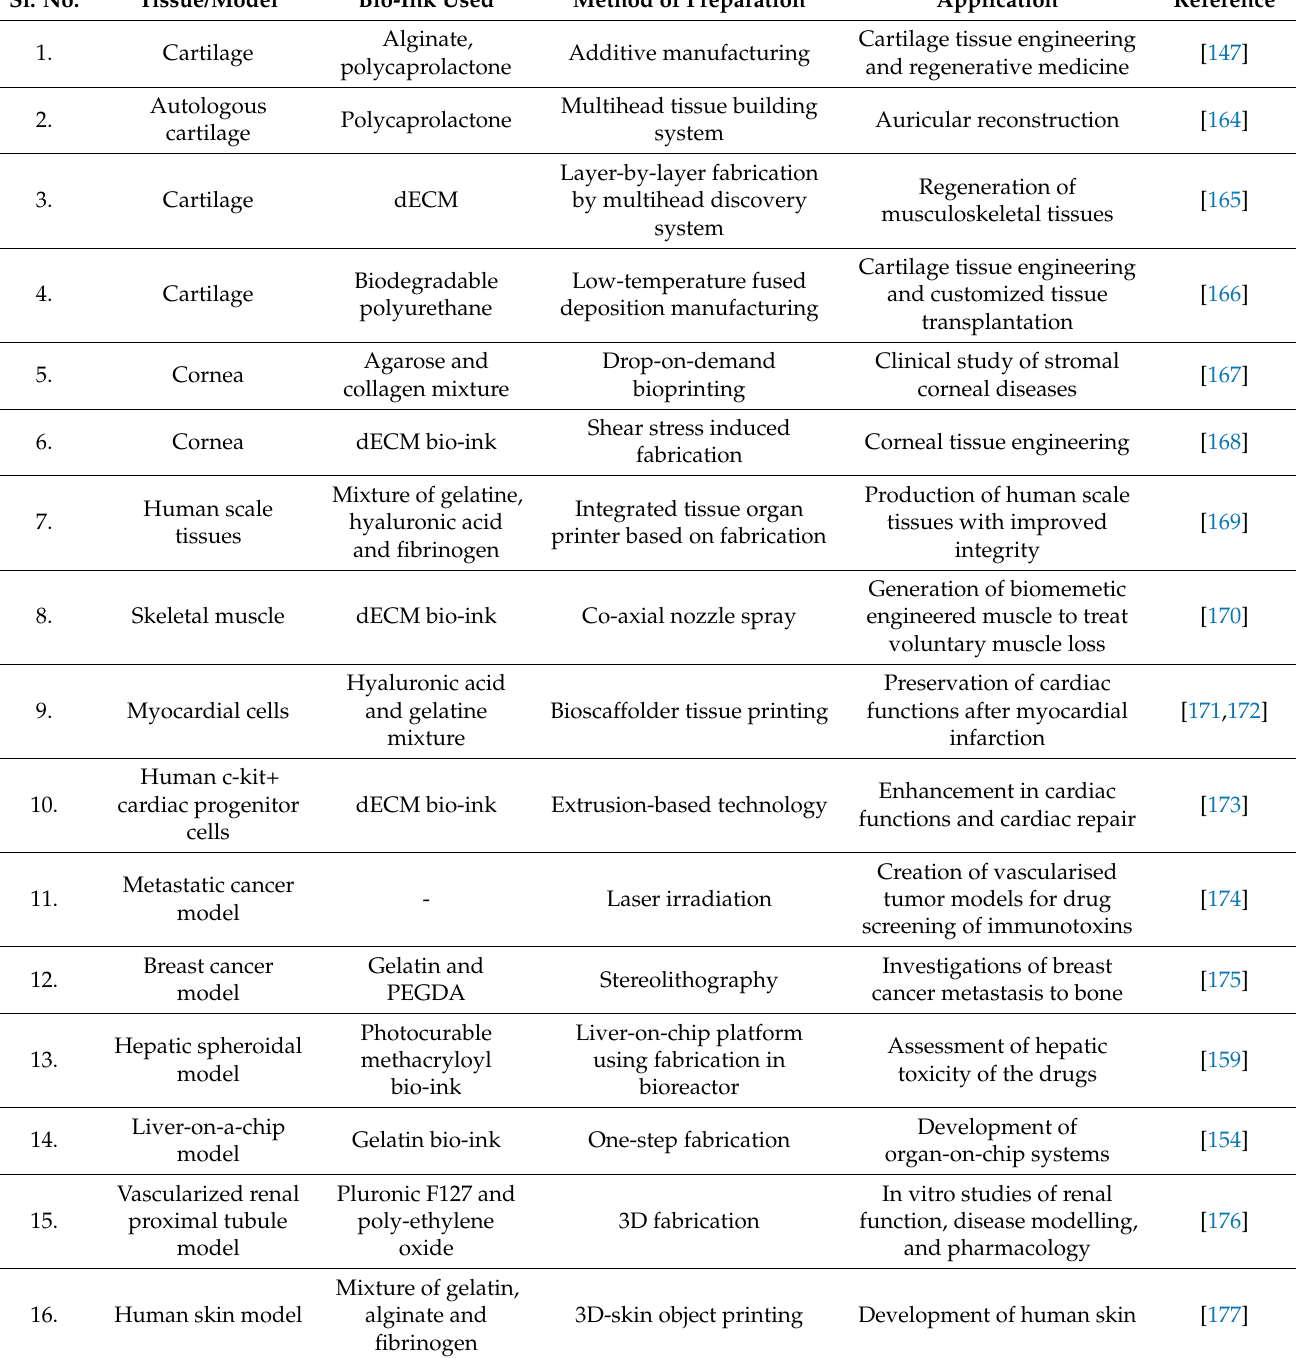
Table 6. Applications of 3D-bioprinting in tissue regeneration, drug screening and drug repositioning. Sl.